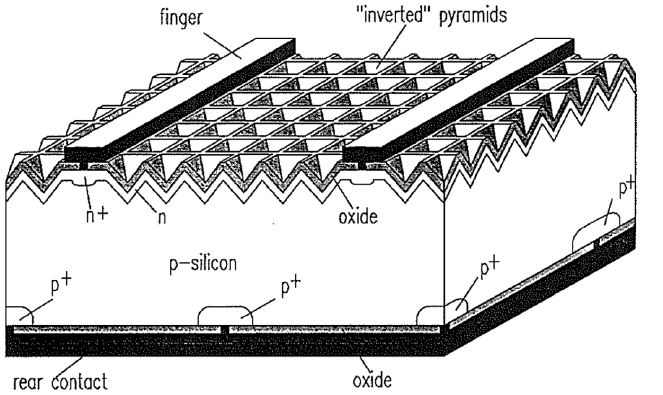
Figure 4. Structure of first PERL cell Reprinted/adapted with permission from Ref. [30]. 1992, Wang, Aihua.